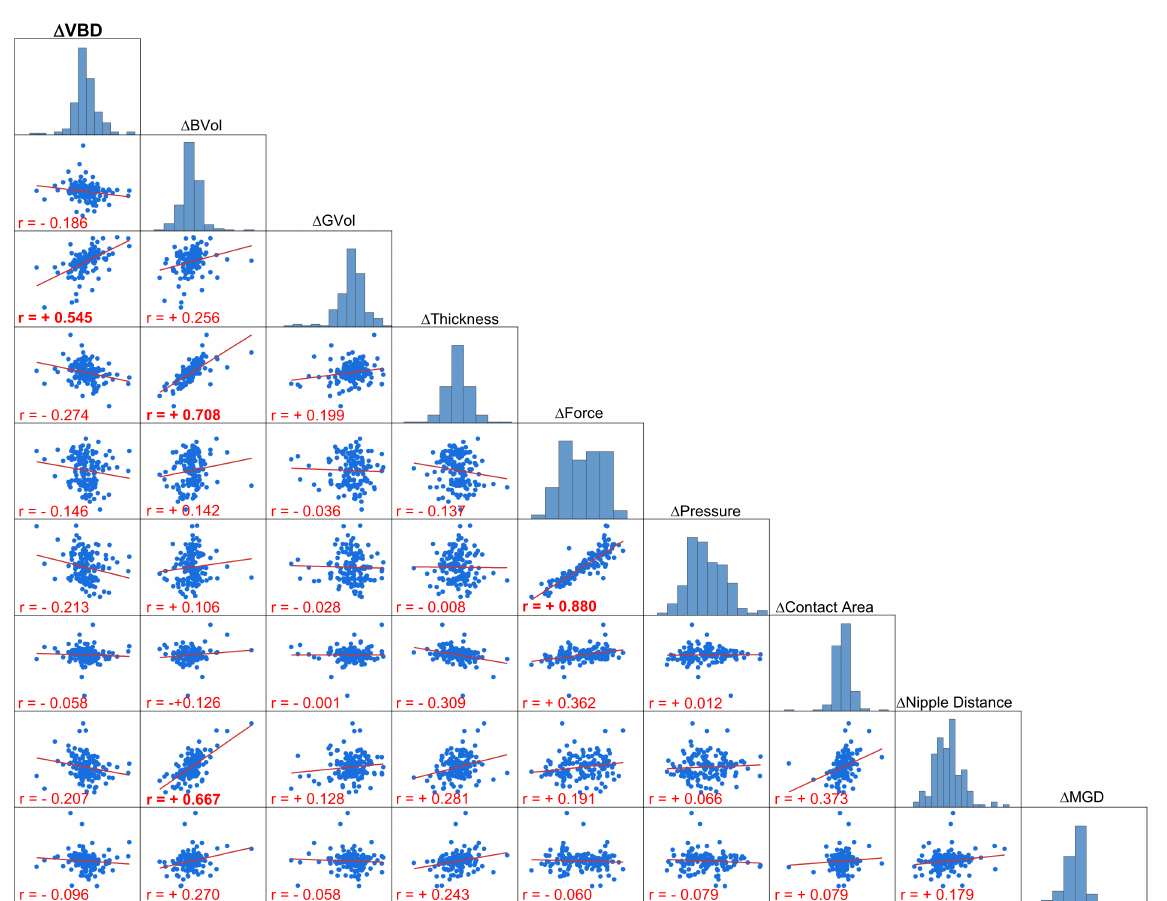
Figure 4. Scatter plot matrix of the VBD differences obtained from CEM and DM/DBT images and their relationship with all the other variable differences considered as independent in the multiple regression model: breast volume, volume of glandular tissue, breast thickness, compression force and pressure, contact area, nipple-to-posterior-edge distance, and mean glandular